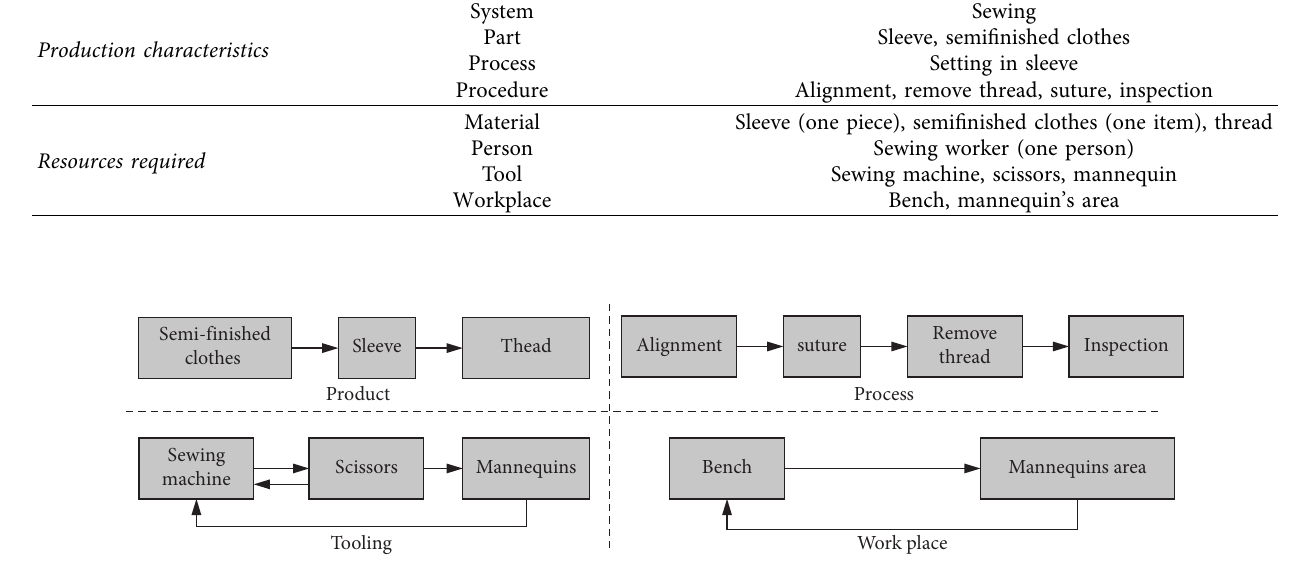
Figure 8: Four types of production information relationships of setting in sleeves.